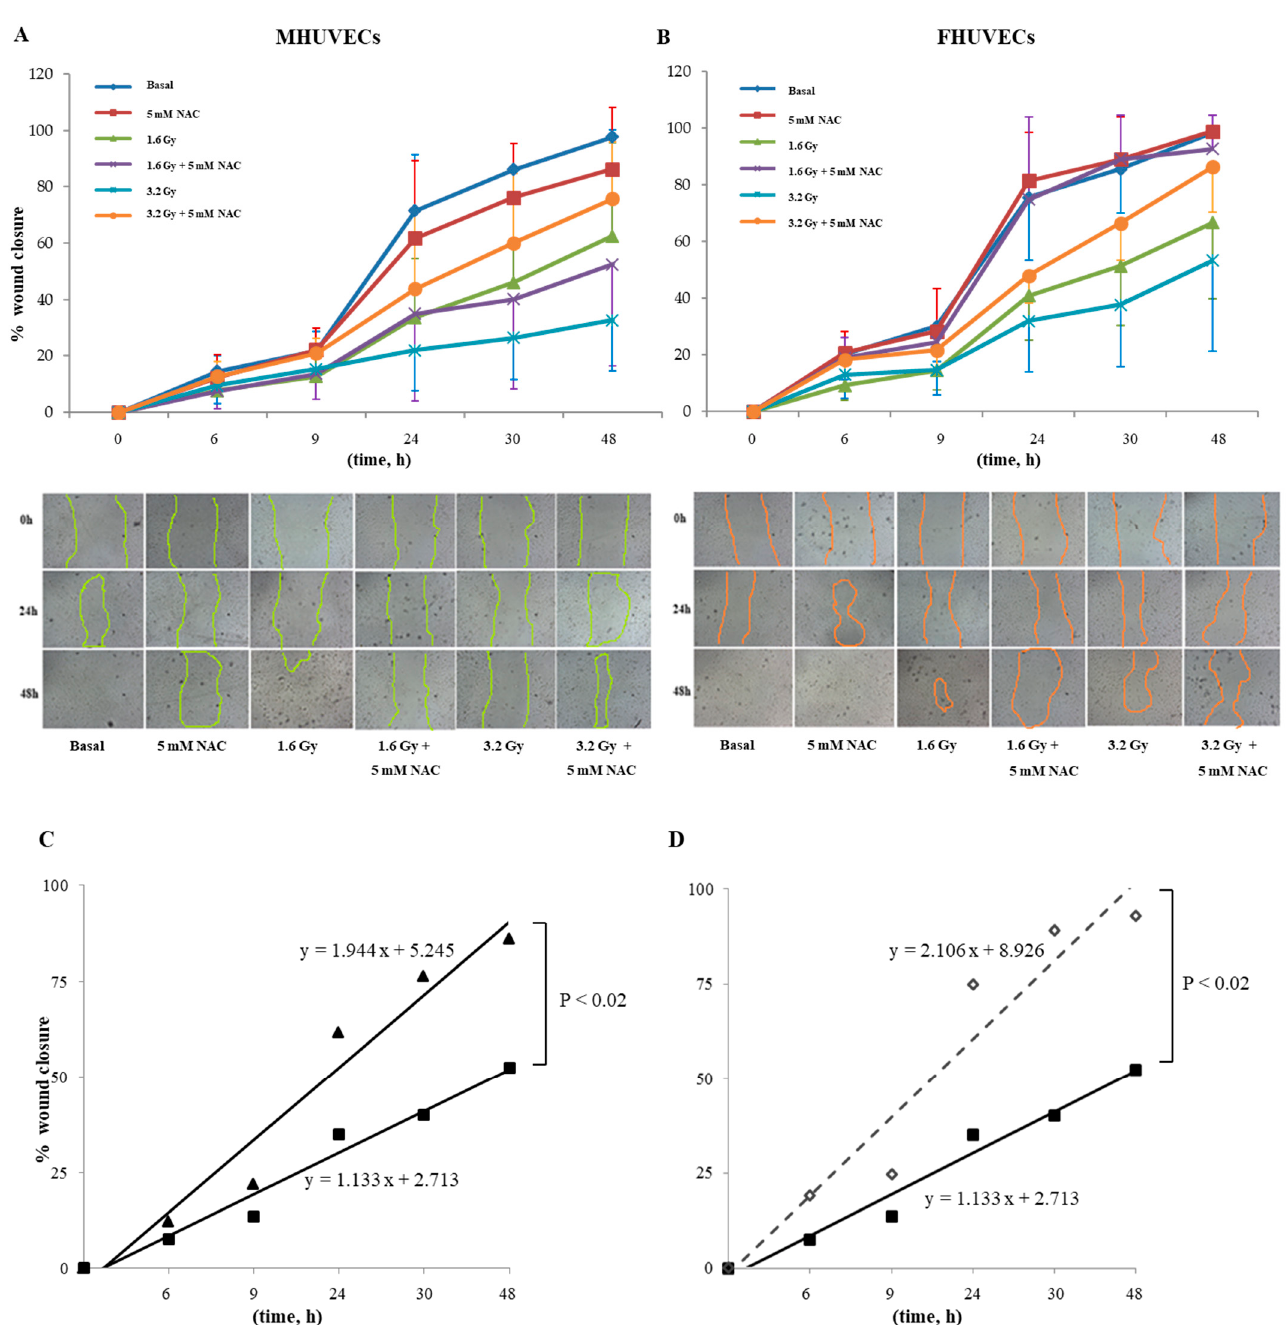
Figure 5. ( A , B ) The effect of 5 mM NAC on the migration of MHUVECs and FHUVECs. ( C , D ) Linear regression analysis of data illustrated in A e B on the migration of 1.6 Gy ‐ irradiated pre ‐ treated with NAC in MHUVECs ( ■ ) and FHUVECs ( ◊ ). ( D ) Linear regression analysis of data illustrated in B of the migration of 1.6 Gy ‐ irradiated MHUVECs pre ‐ treated with NAC ( ■ ) and non ‐ irradiated MHUVECs pre ‐ treated with NAC ( ▲ ).